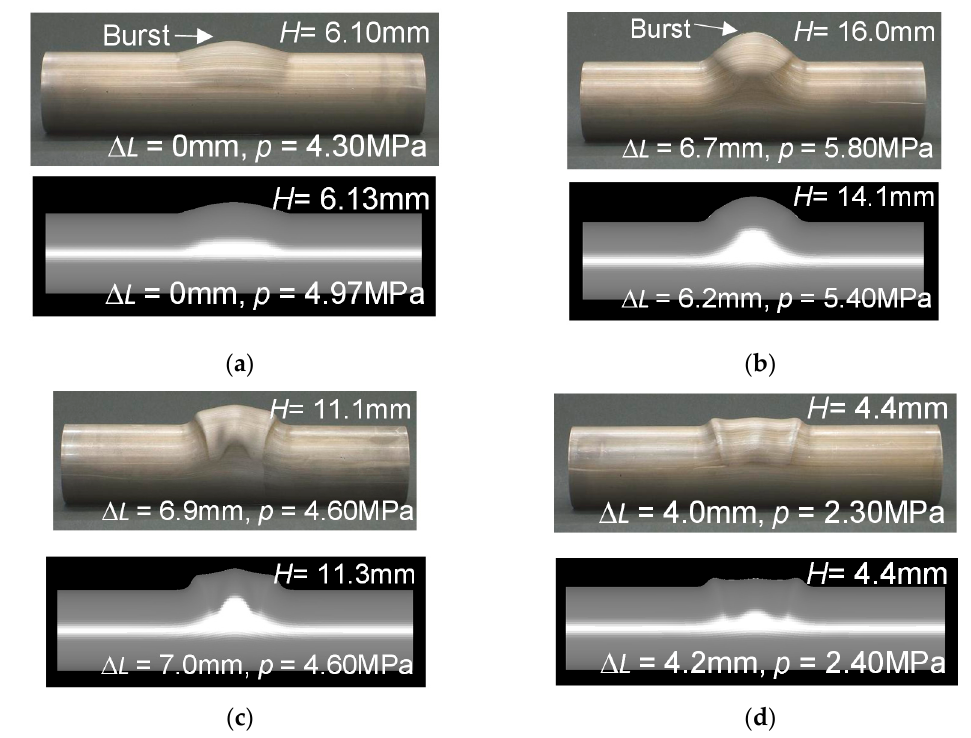
Figure 8. Comparisons of final bulged shape between experimental and simulated results at T-shape forming limit for AZ31B tube in a proportional loading under 250 °C. ( a ) Path ① in Figure 7; ( b ) Path ② ; ( c ) Path ③ ; ( d ) Path ④ .